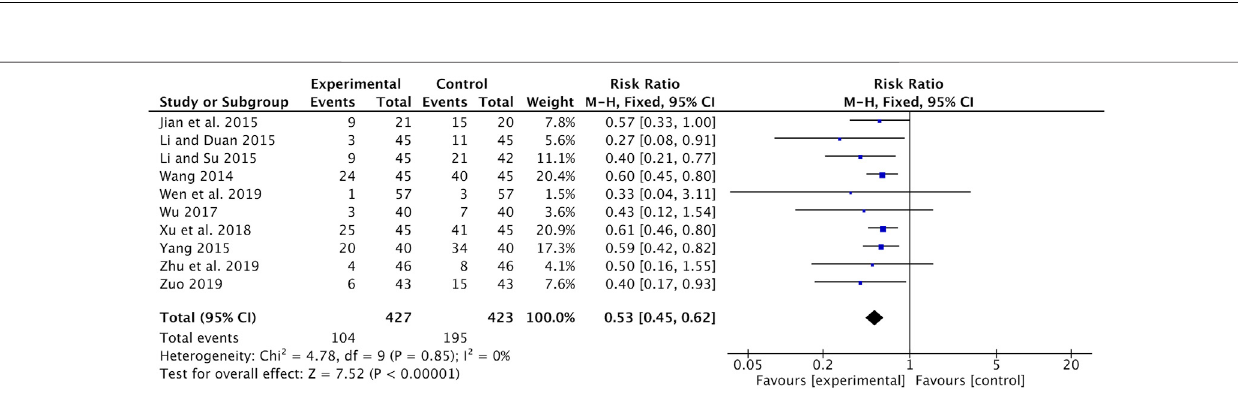
Frontiers in Pharmacology |